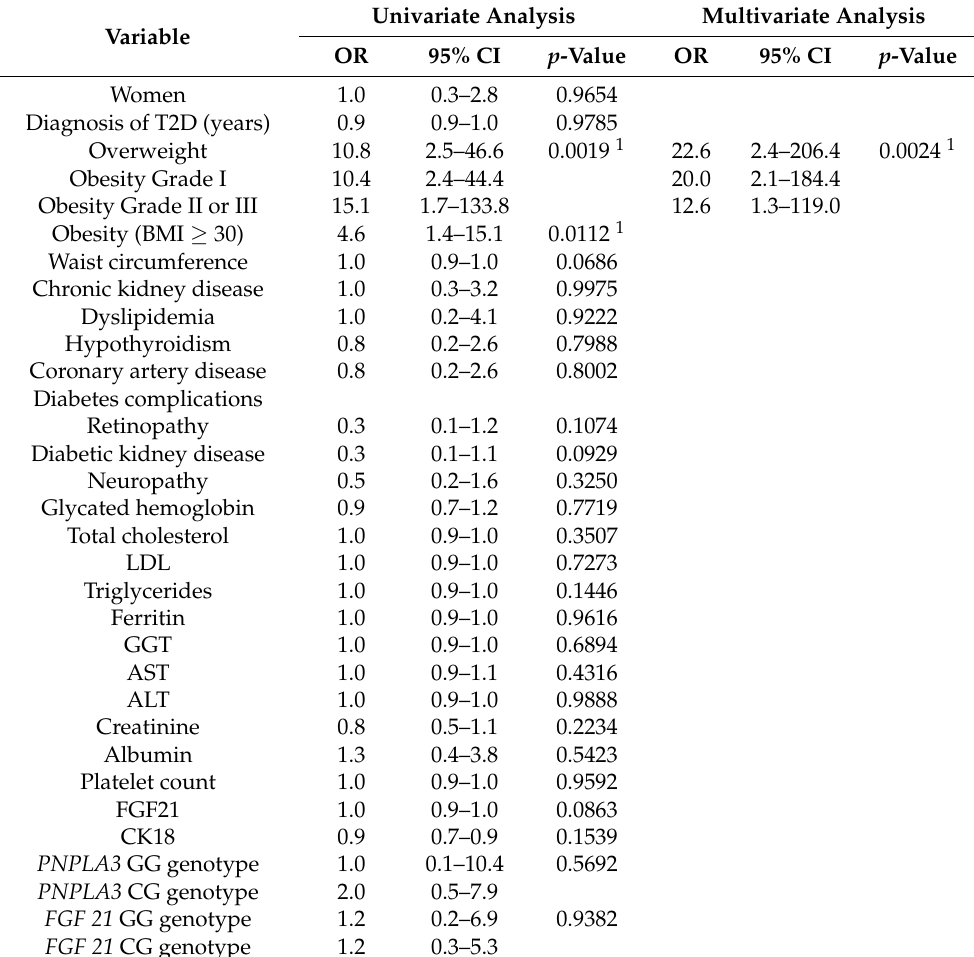
Table 2. Factors associated with NAFLD in patients with T2D ( n =